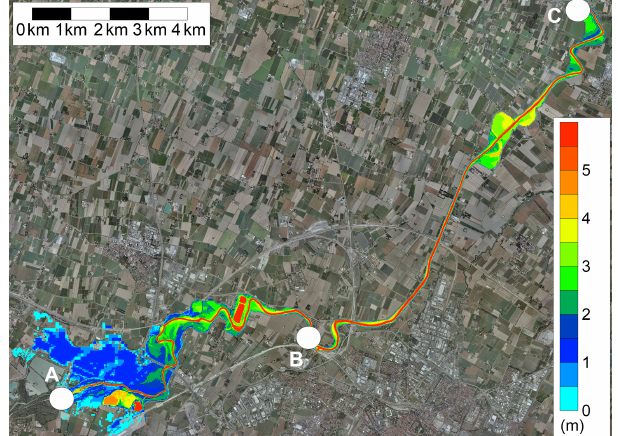
Figure 11. Map of the water depths at the flood peak occurrence on the Secchia River, with indication of the upstream (A) and down- stream (C) boundary conditions and the intermediate observation site (B).